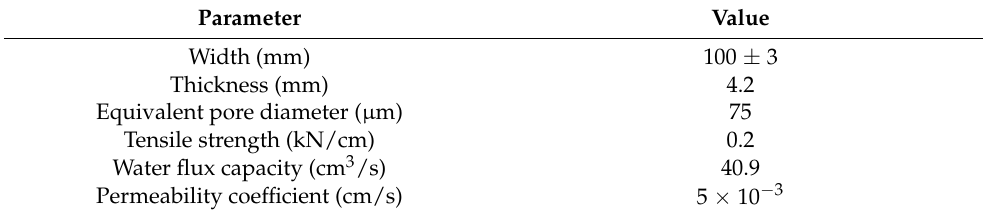
Table 1. Parameters of